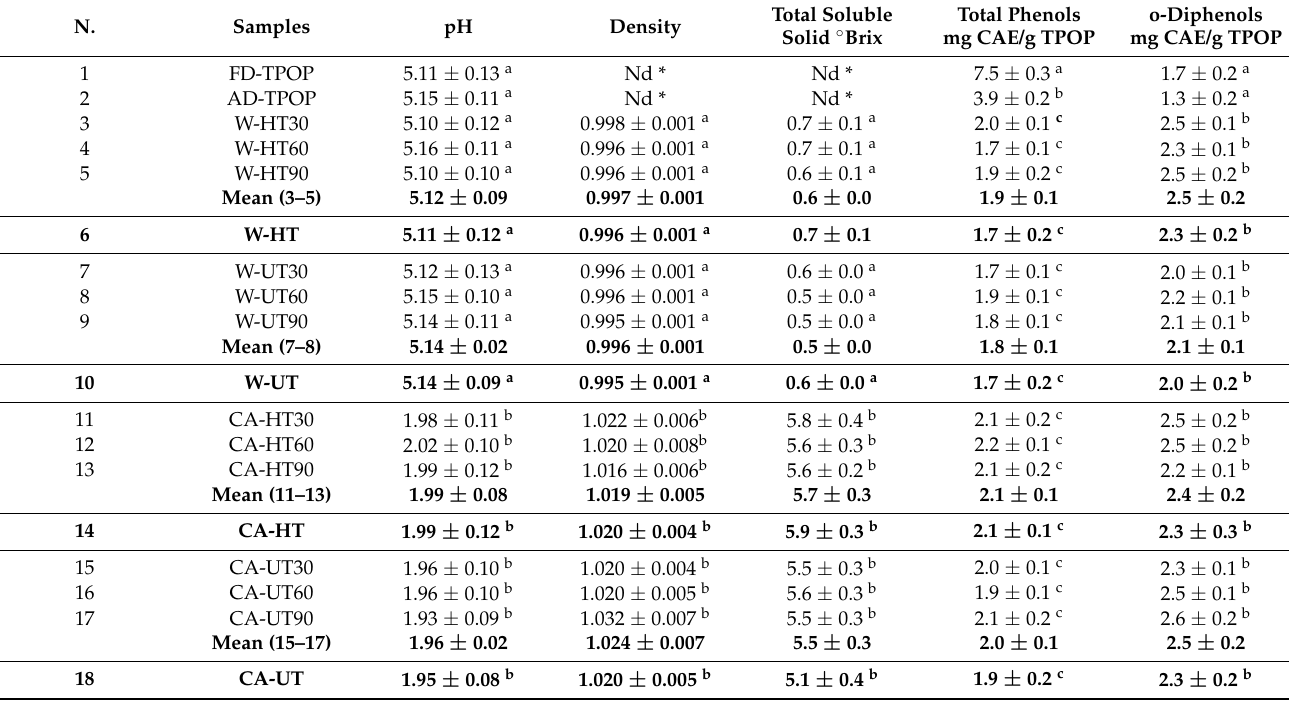
Table 3. Determinations conducted on the samples. Different letters within the column indicate a significant difference at p ≤